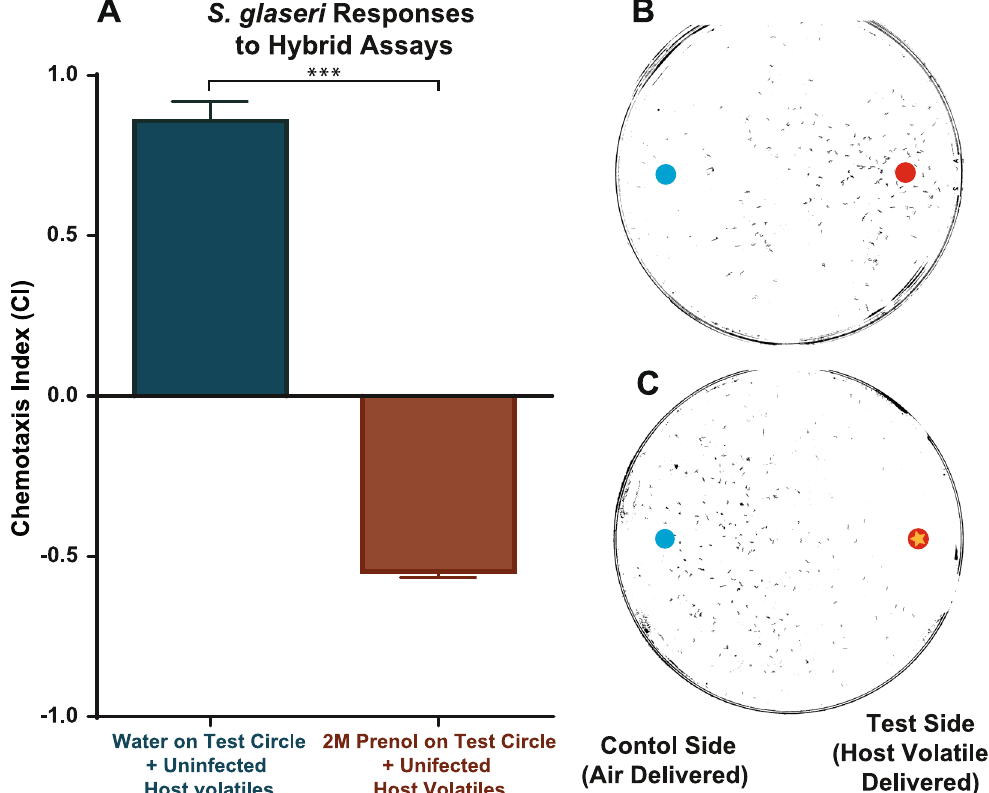
Figure 7. Hybrid Assay results. ( A ) Chemotaxis index for hybrid assays done with S . glaseri IJs. Statistical analysis done using a two-tailed, paired, parametric t-test. Error bars represent SEM, *** P < 0.001 ( B ) A representative photo of a control hybrid assay using volatile and soluble cues, in this experiment 5 µ l of ultrapure water was placed on the agar plate underneath where uninfected host volatiles were being delivered. The blue dot (on left side of the plate) represents the location of where air from control syringe was delivered, and the red dot (on right side of the plate) represents where volatiles from uninfected hosts was delivered. ( C ) A representative photo of a hybrid assay where 5 µ l 2 M prenol–diluted in ultra-pure water–was added to the test circle–where uninfected host volatiles were being delivered. The combination of prenol and uninfected host volatiles is indicated by red dot with gold star. The blue dot (on left side of plate) indicates where air from control syringe was being delivered. Error bars represent SEM. *** P <